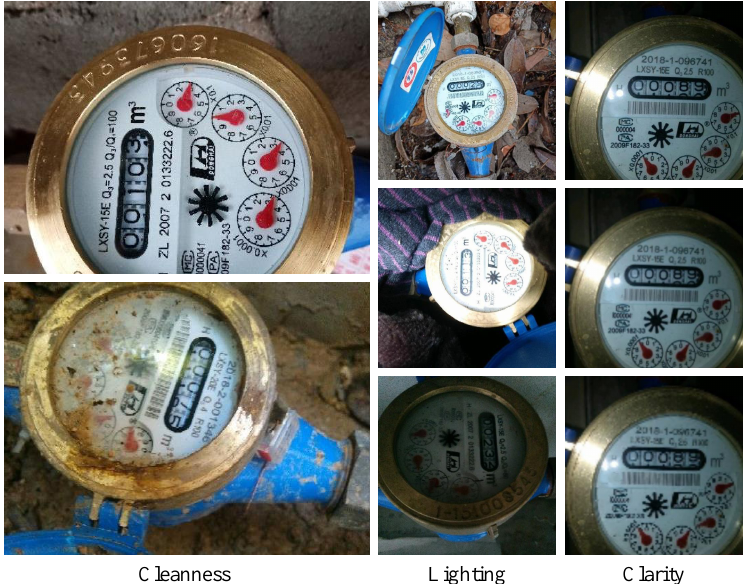
Figure 12. The test dataset images with different cleanliness, lighting and clarity. Table 4. The quantitative experiments for the pipeline’s robustness. “Down × n ” means zoom out n times and then zoom in to the original image. The evaluation metrics are the digit error and the pointer error. Digit